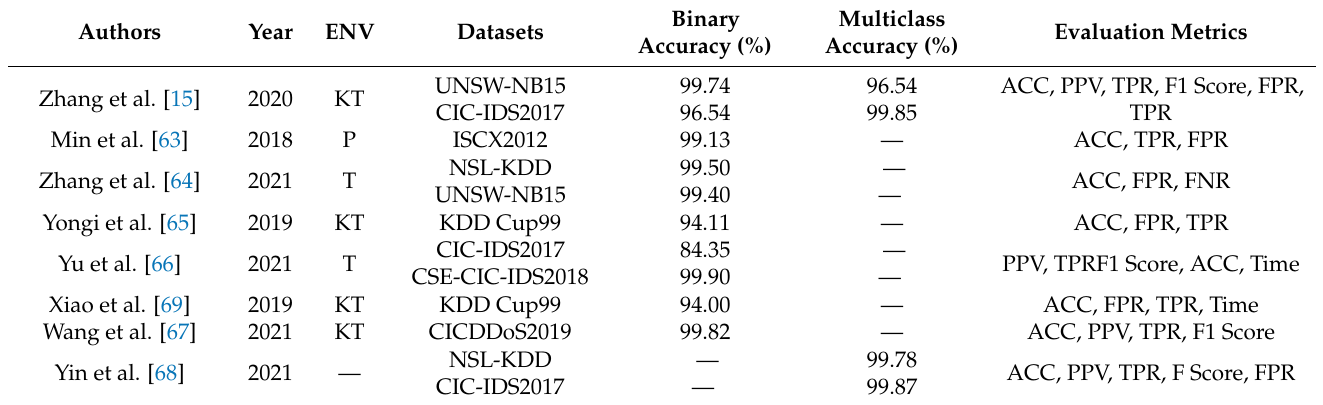
Table 9. Properties of group 3 (Hybrid CNN and Deep Learning) IDS schemes.